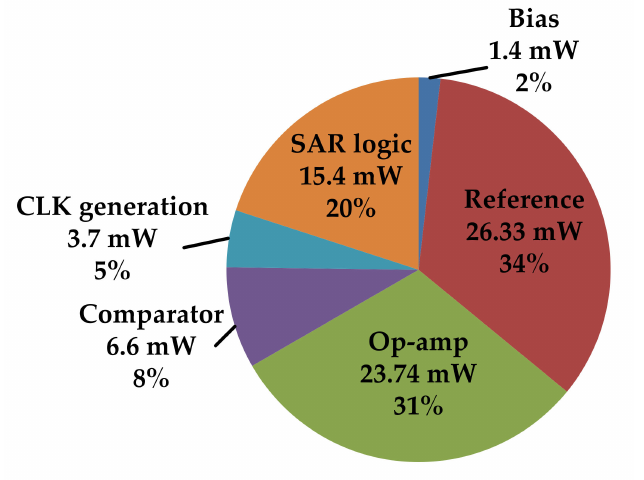
Figure 15. Power breakthrough of the proposed ADC. The power consumption of each block is annotated with its percentage. With the reference/op-amp sharing, 30% power is saved from the reference and op-amp, which are the most power-hungry